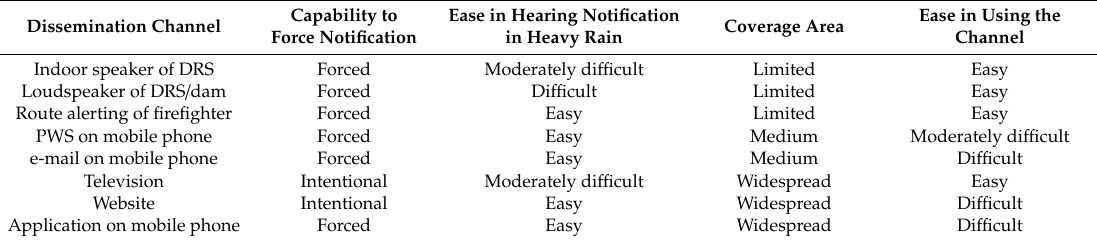
Table 7. Characteristics of major dissemination channels of warnings.